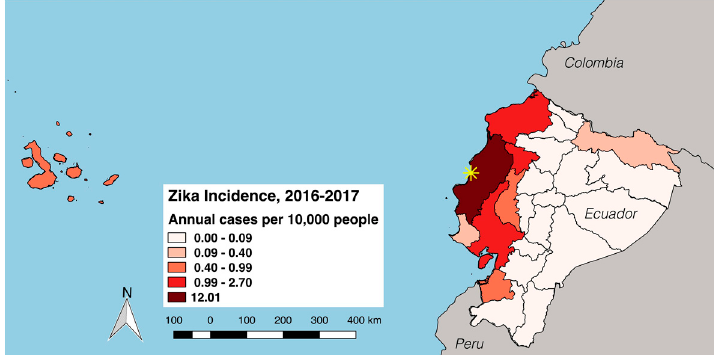
Figure 1. Annual ZIKV incidence per province in Ecuador, from epidemiological week (EW) 1 in 2016 to EW 38 in 2017 (cases per 10,000 people). The site of this study (Bahía de Caráquezf, Manabí Province) is indicated by the yellow asterisk. The earthquake epicenter was located 124 km northwest of Bahía de Caráquez. Data provided by the Ministry of Health of Ecuador [4].